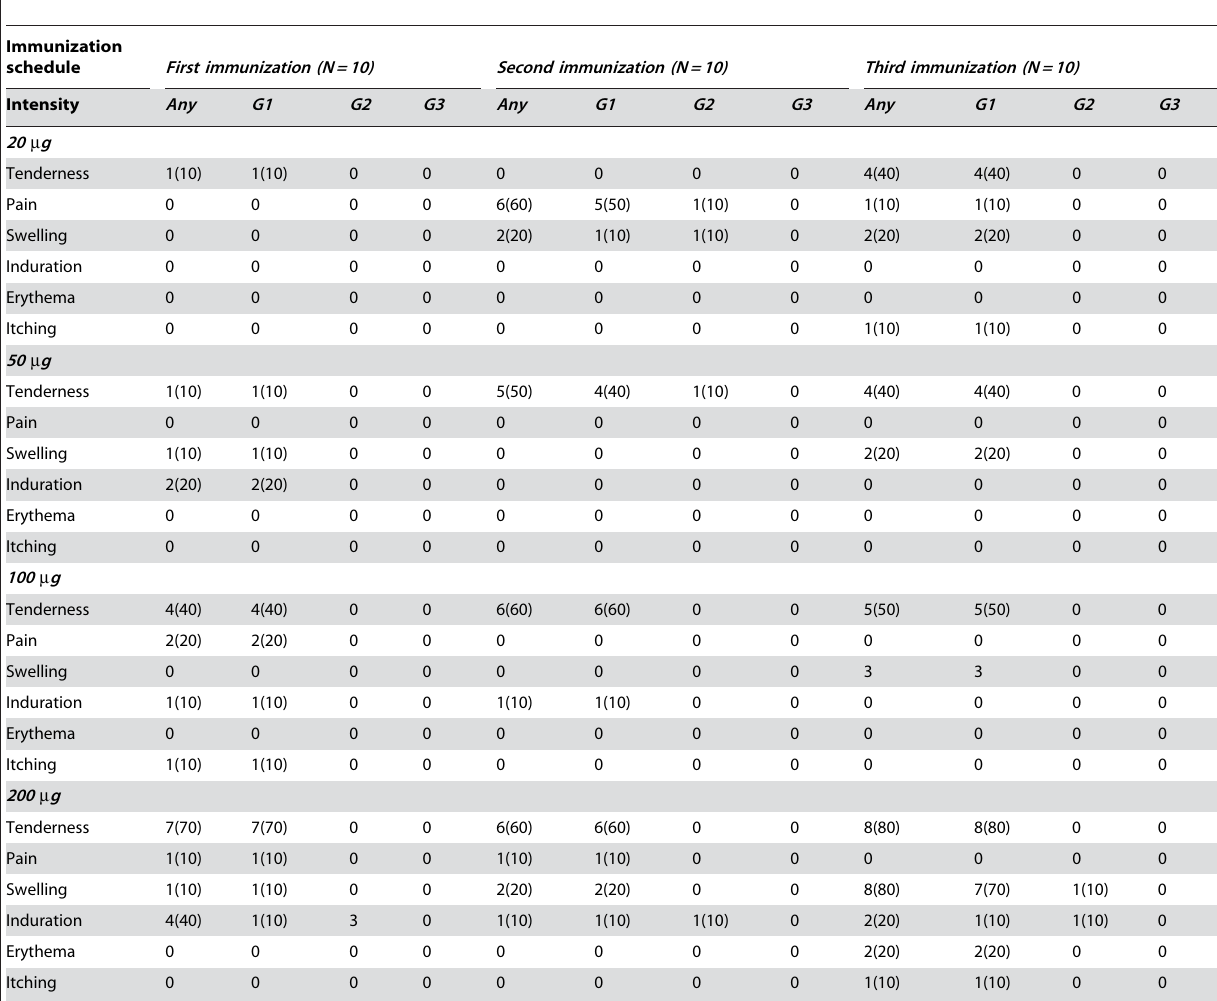
Table 2. Number (percentage) of subjects experiencing local solicited adverse events for each study arm receiving vaccine, by intensity grade for each